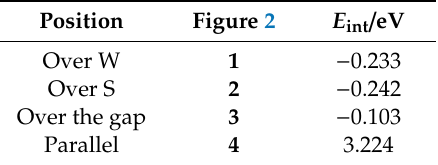
Table 2. Interaction energies associated to the binding sites from Figure 2. Position Figure 2 E int / eV Over W 1 − 0.233 Over S − 0.242 Over the gap − 0.103 Parallel 3.224